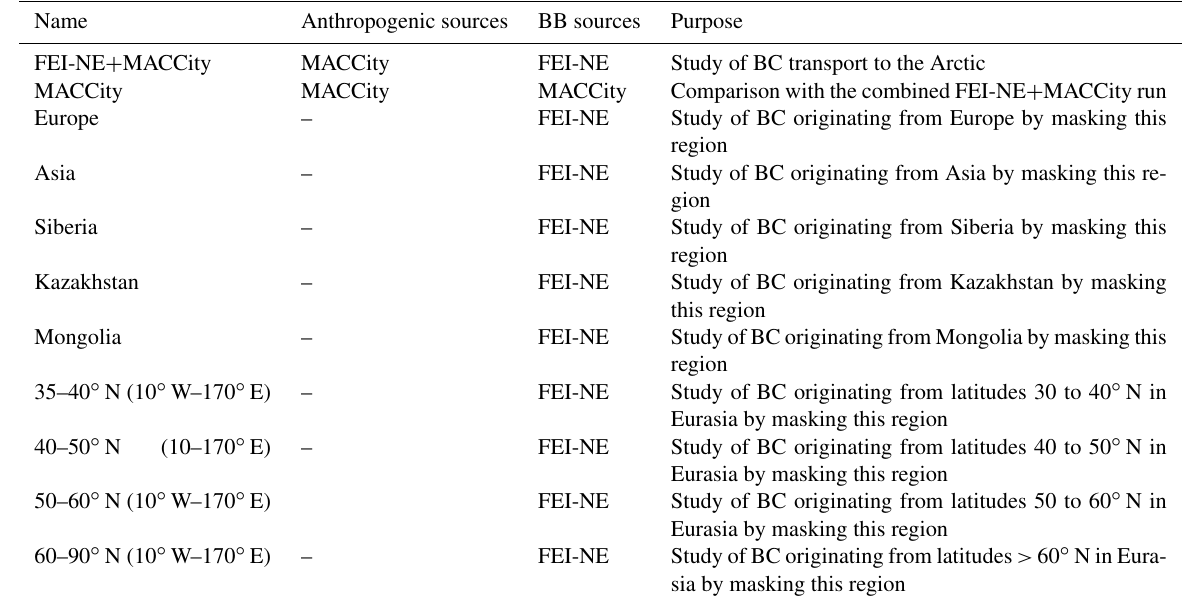
Table 1. List of simulations from this study to characterize the transport and origin of BC. Name Anthropogenic